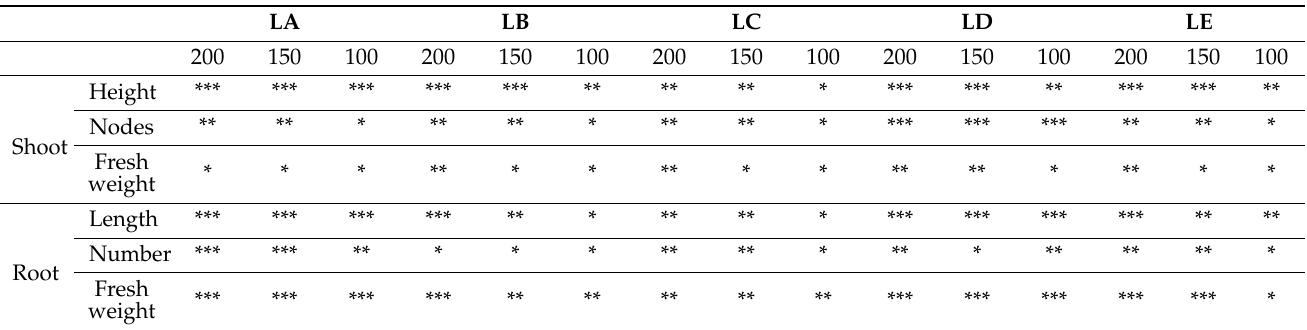
Table 2. Effect of salt stress, expressed as classes of IS values, on the different morphological parameters of five alfalfa lines grown for 10 weeks on a basal medium enriched with different salt concentrations.